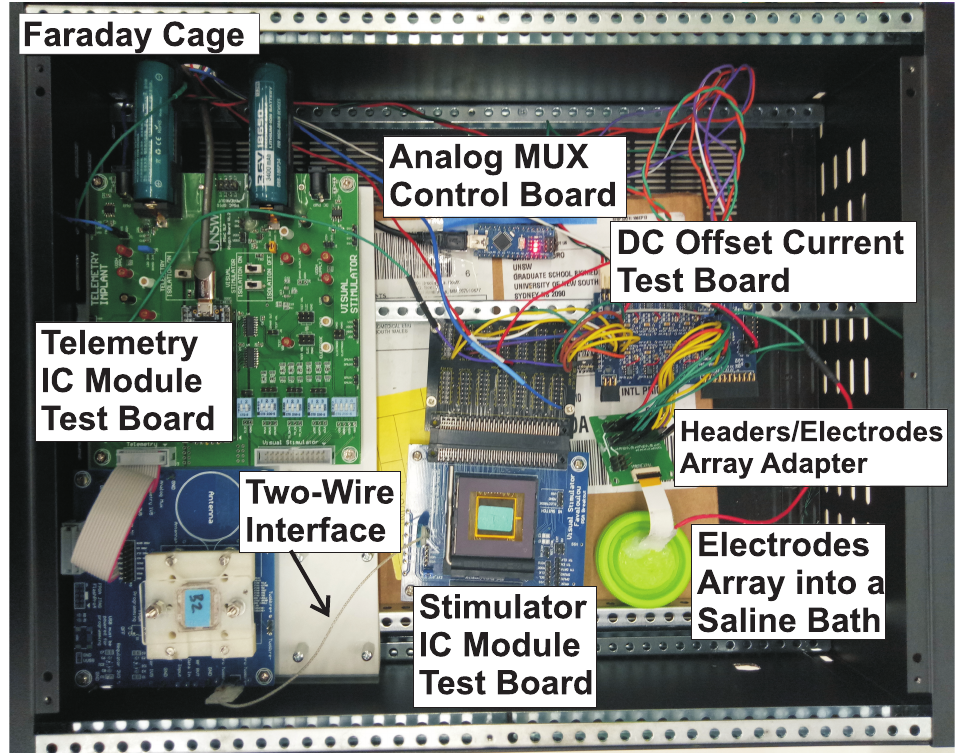
Figure 3. DC offset current measurement setup inside the metal enclosure as depicted in Figure